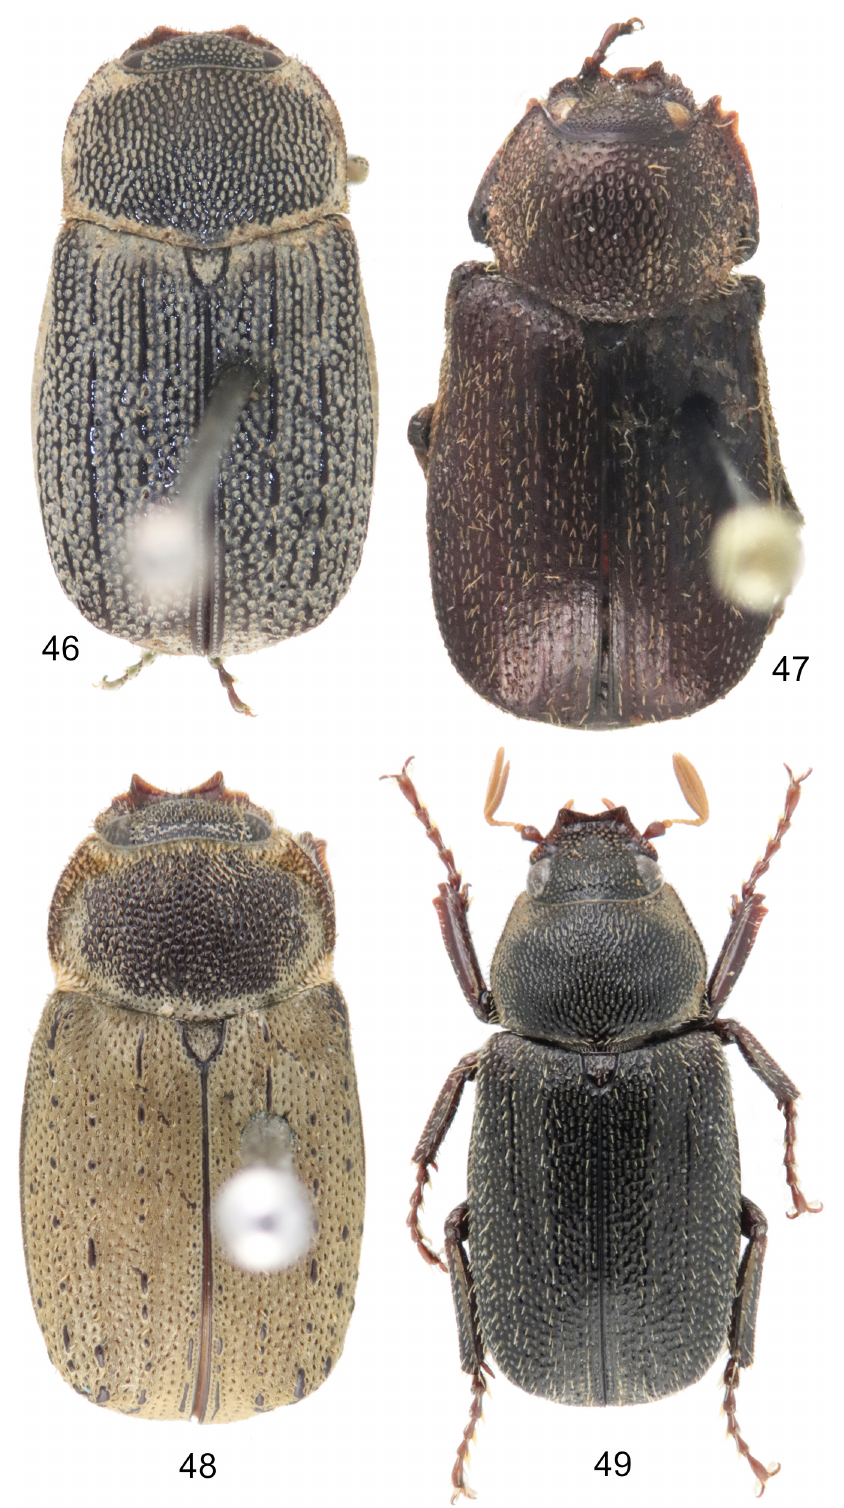
Figs 46–49. Papuan and Wallacean Maechidius Macleay, 1819, habitus, dorsal